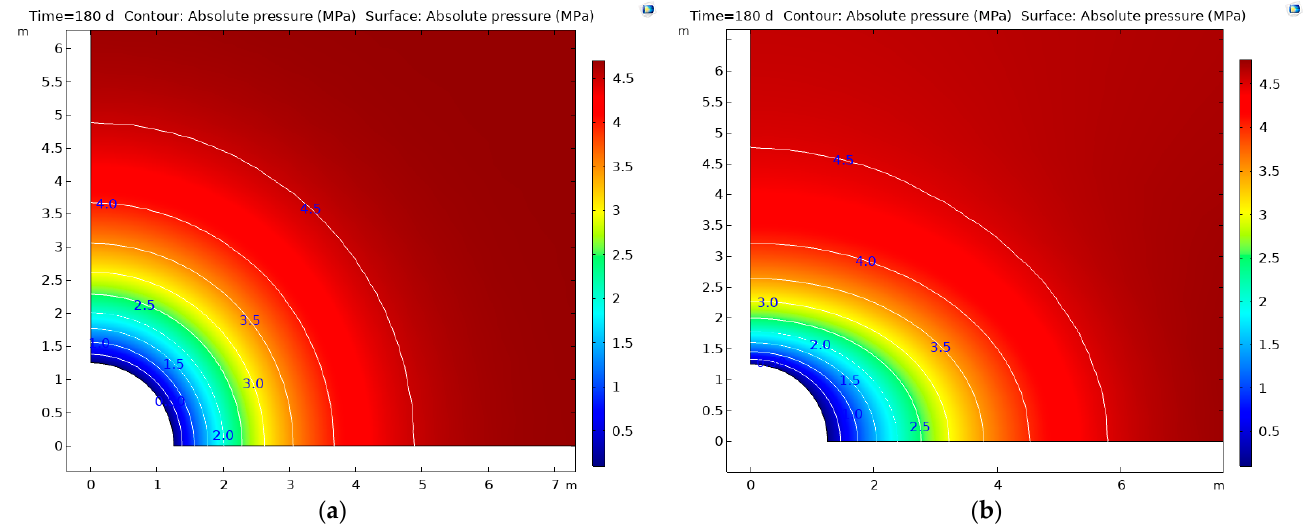
Figure 5. DC variant: distribution of pore pressure at the end of the waiting phase (after 180 days of simulation) ( a ) in the case of isotropic stress conditions and isotropic properties: ( b ) in the case of anisotropic stress and anisotropic properties.